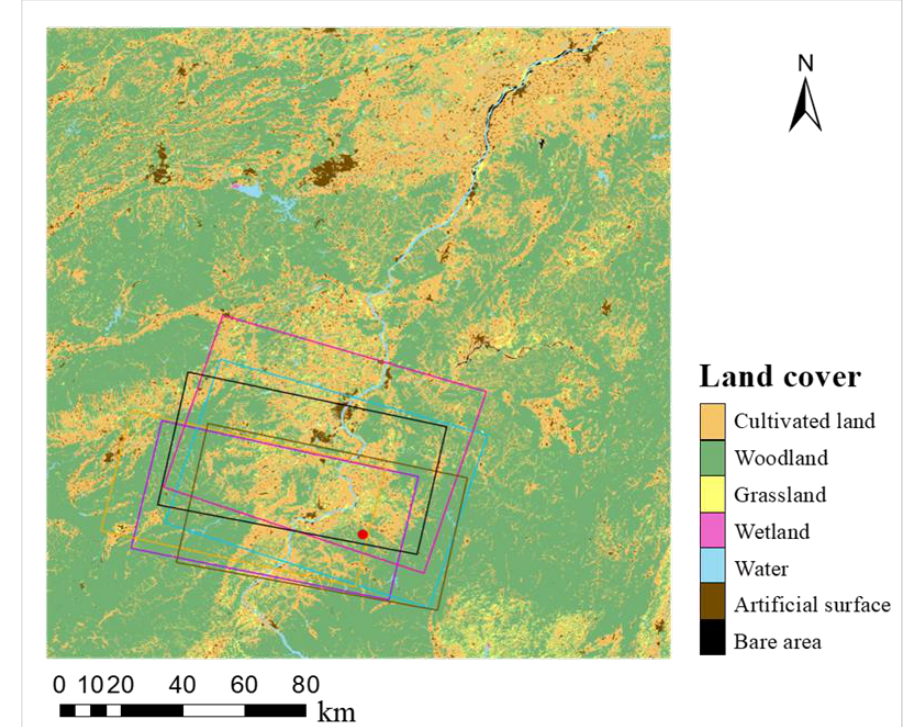
Figure 10. The location of the study site (red point) and the rectangular area is the solar-induced chlorophyll fluorescence (SIF) pixel (40 km × 80 km) of the Global Ozone Monitoring Experiment-2 (GOME-2) in the same period, and the background is a land cover image derived from GlobeLand30. It can be seen that the vegetation type in SIF pixels is mainly cultivated land, and the composition proportion of each vegetation type still changed.